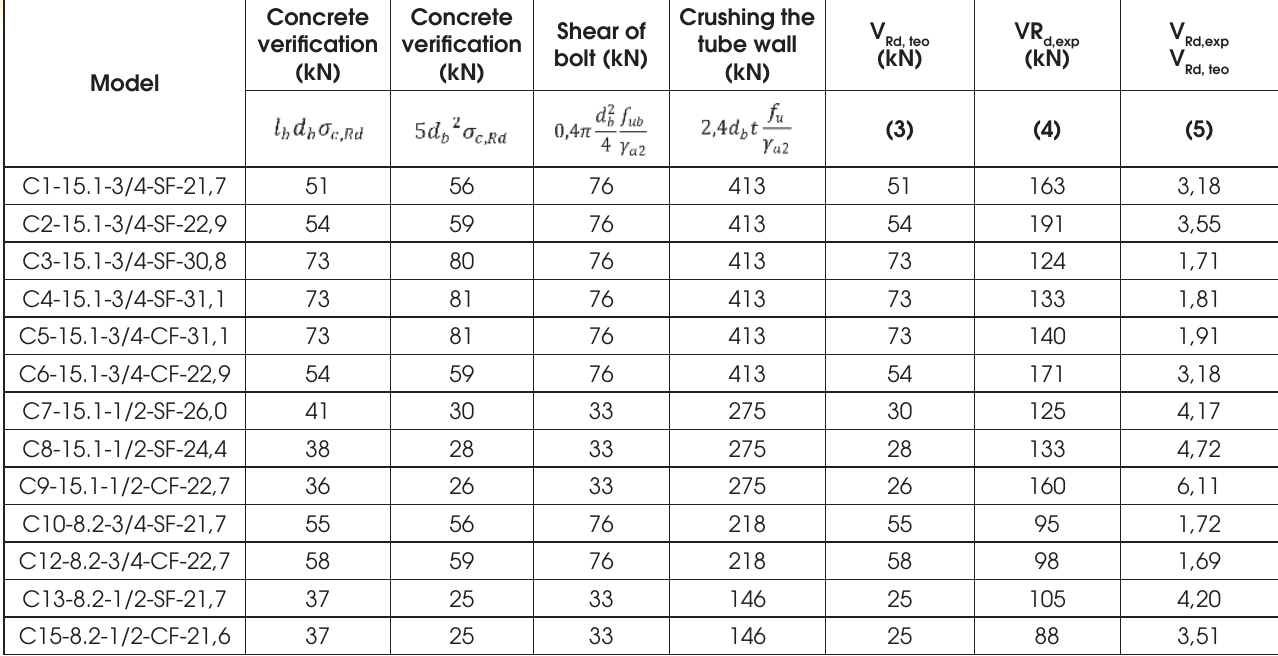
Comparison of resistance of shear connectors